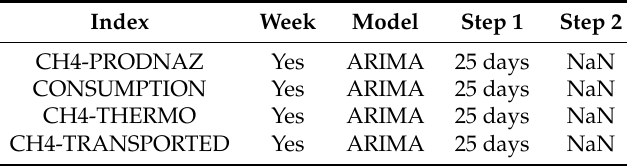
Table A2. Synthesis of state–space models used for energy at daily frequencies.